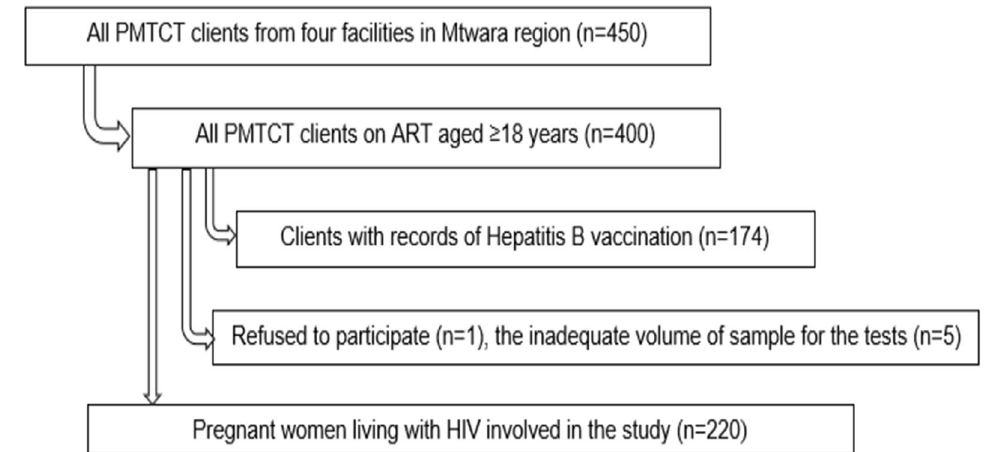
Fig. 1 A scheme showing the data of HIV-infected pregnant women attending PMTCT clinics in the Mtwara